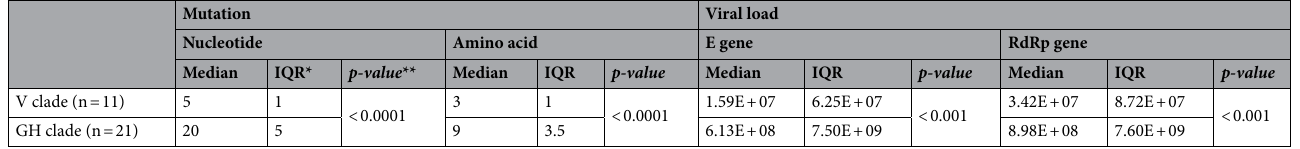
Table 2. Statistical analysis showing significant difference between viral load and number of mutation in the two clades from the clinical samples of the patients with COVID-19. *Interquartile range. **Probability